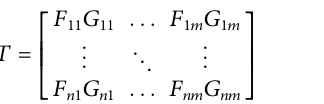
Frontiers in Physics |